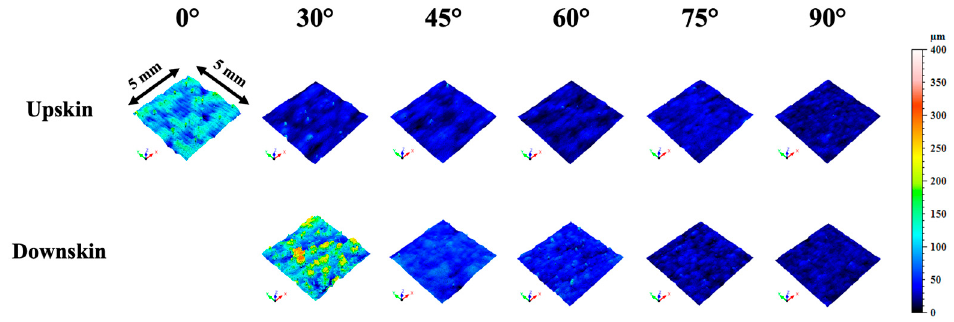
Figure 5. Three-dimensional color surfaces acquired from the overhanging elements of a self- supported L-PBF structure.